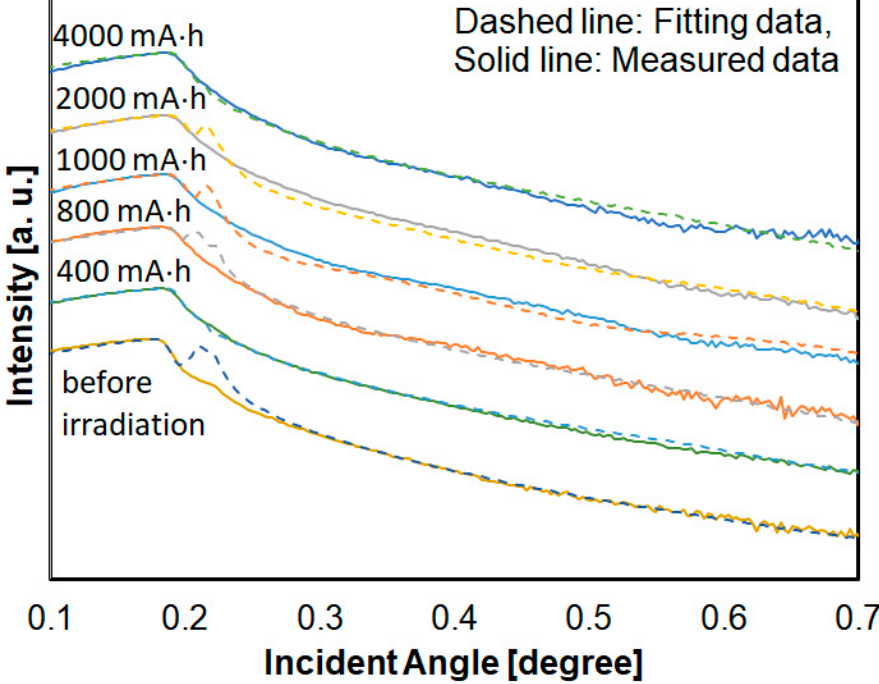
Figure 3. XRR profiles and fitting results of hydrogenated Si-DLC film.